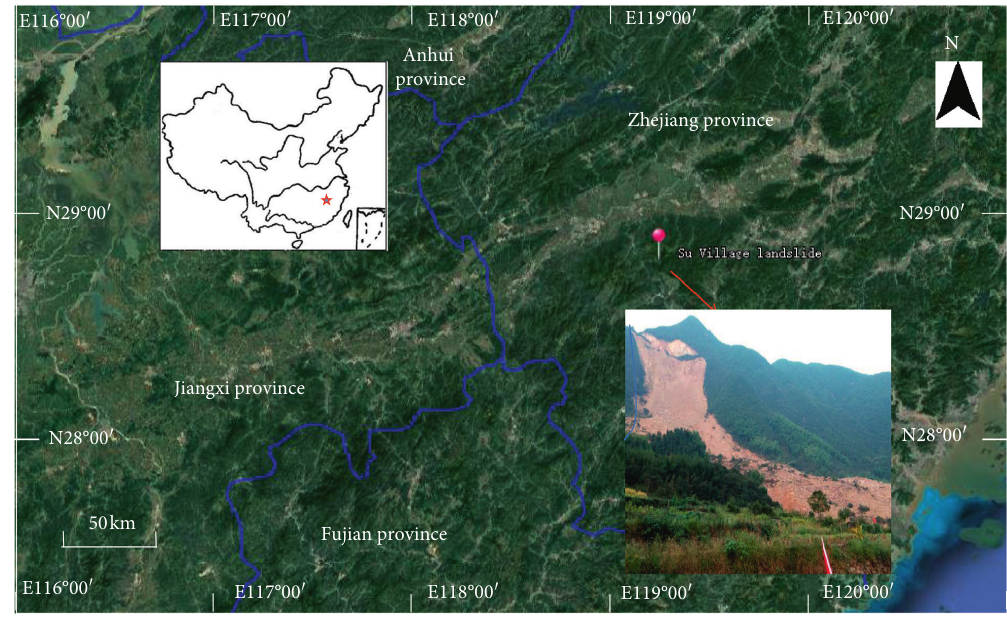
Figure 1: Location of the Sucun landslide in the Suichang